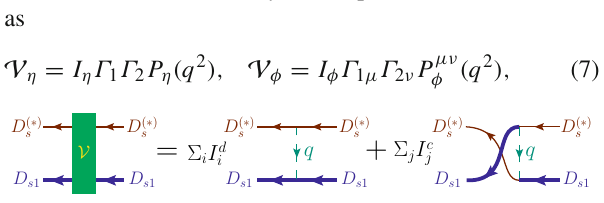
Fig. 1 The diagrams for the direct (left) and cross (right) potentials. The thin (brown) and thick (blue) lines are for D ( ∗ ) and D s 1 mesons,